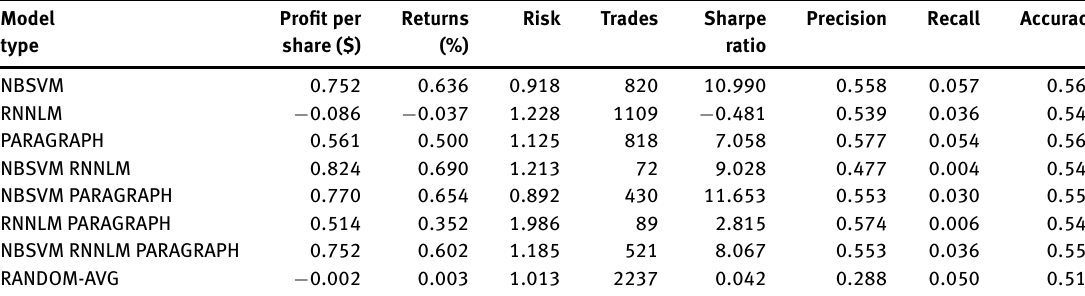
Table 8: 60-Min Language Model Metrics on Testing Set.